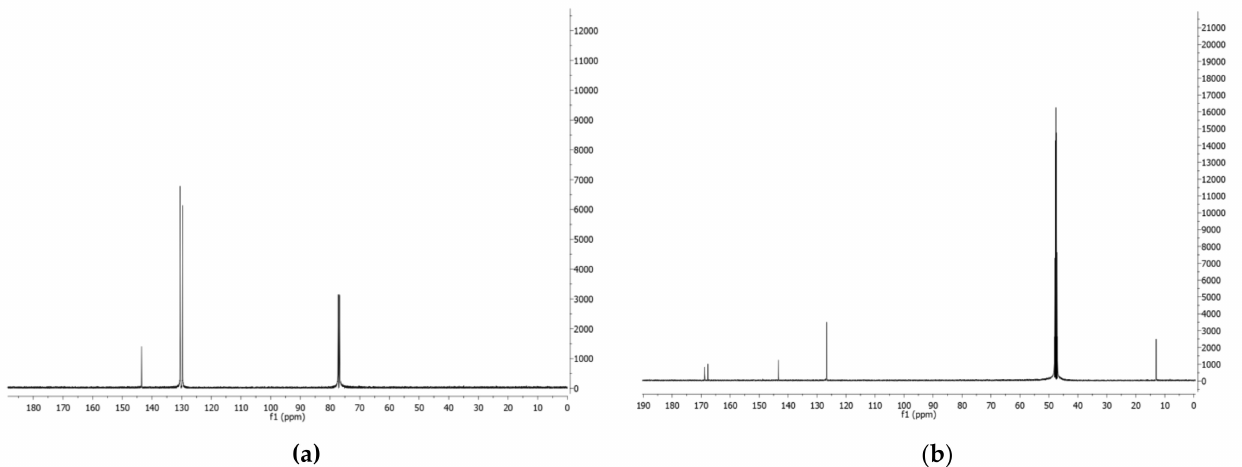
Figure 4. ( a ) 13 C-NMR spectrum of phenazine ( 1 ) recorded in CDCl 3 at 125 MHz; ( b ) 13 C-NMR spectrum of mesaconic acid ( 2 ) recorded in CD 3 OD at 125 MHz.